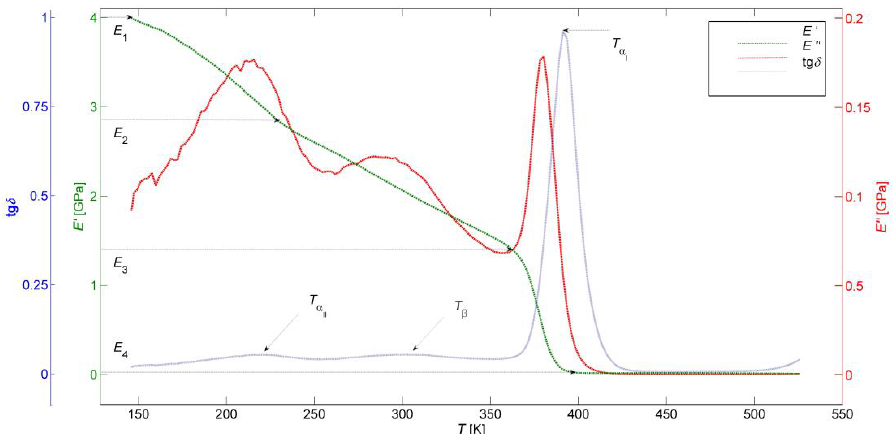
Figure 1. Temperature dependences of the average storage modulus E ′( T ), loss modulus E′′ ( T ), and damping factor tan δ ( T ) of tested thermoplastic polyurethanes (TPU) at a frequency of 1 Hz in the whole temperature range of its service life.